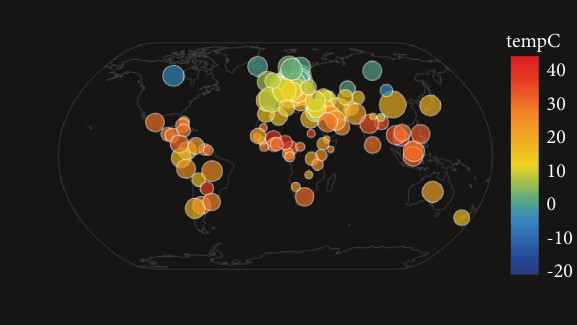
Figure 6: The relationship of humidity with coronavirus spread.